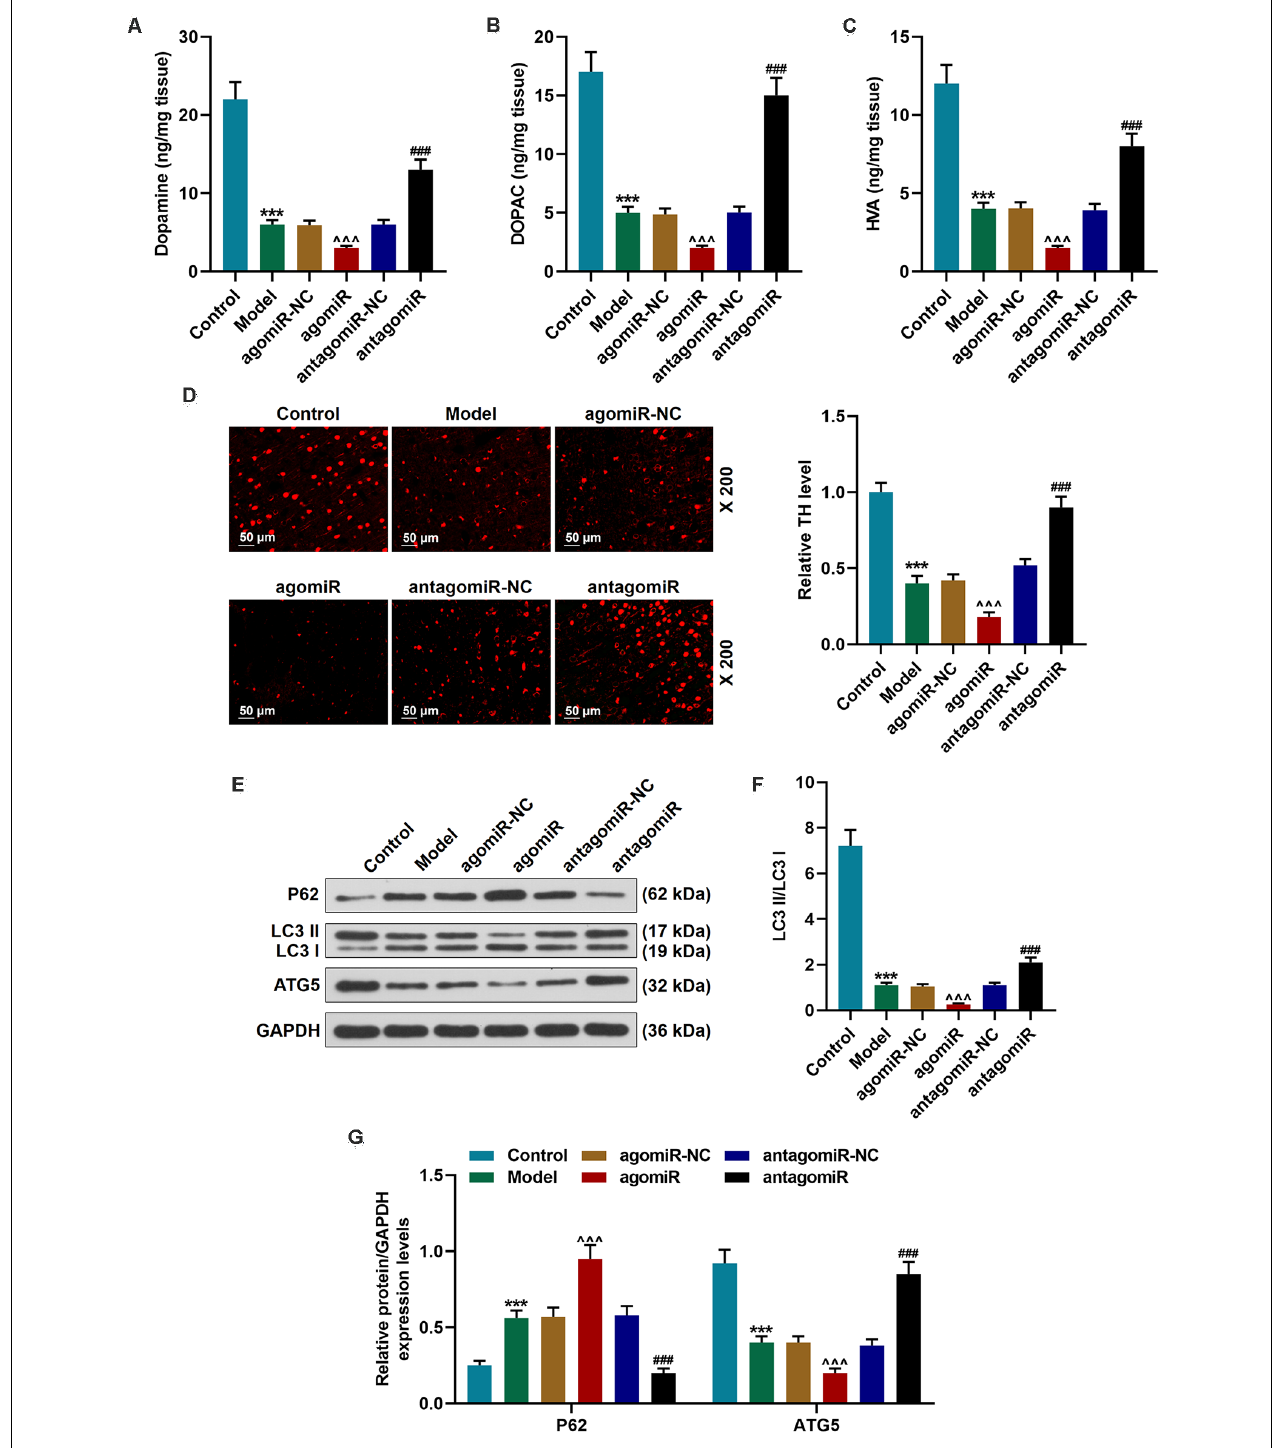
FIGURE 2 | Detection of dopamine metabolic markers, tyrosine hydroxylase (TH), and autophagy pathway-associated proteins in PD mice after transfection of miR-30c-5p overexpression or knockdown. (A–C) Dopamine metabolic markers dopamine, dihydroxyphenylacetic acid (DOPAC), and homovanillic acid (HVA) were detected using Diode Array Detector (DAD). (D) The level of TH in the Substantia nigra pars compacta (SNpc) was determined by immunofluorescence. Scale bar = 50 µ m. 200 × . (E–G) Western blot analysis of the expressions of autophagy-related proteins (p62, LC3 II, and LC3 I, ATG5) in brain tissues. The ratio of LC3 II to LC3 I was calculated. GAPDH served as an internal control. *** p < 0.001 vs. control group. ∧∧∧ p < 0.001 vs. agomiR NC group. ### p < 0.001 vs. antagomiR NC group.